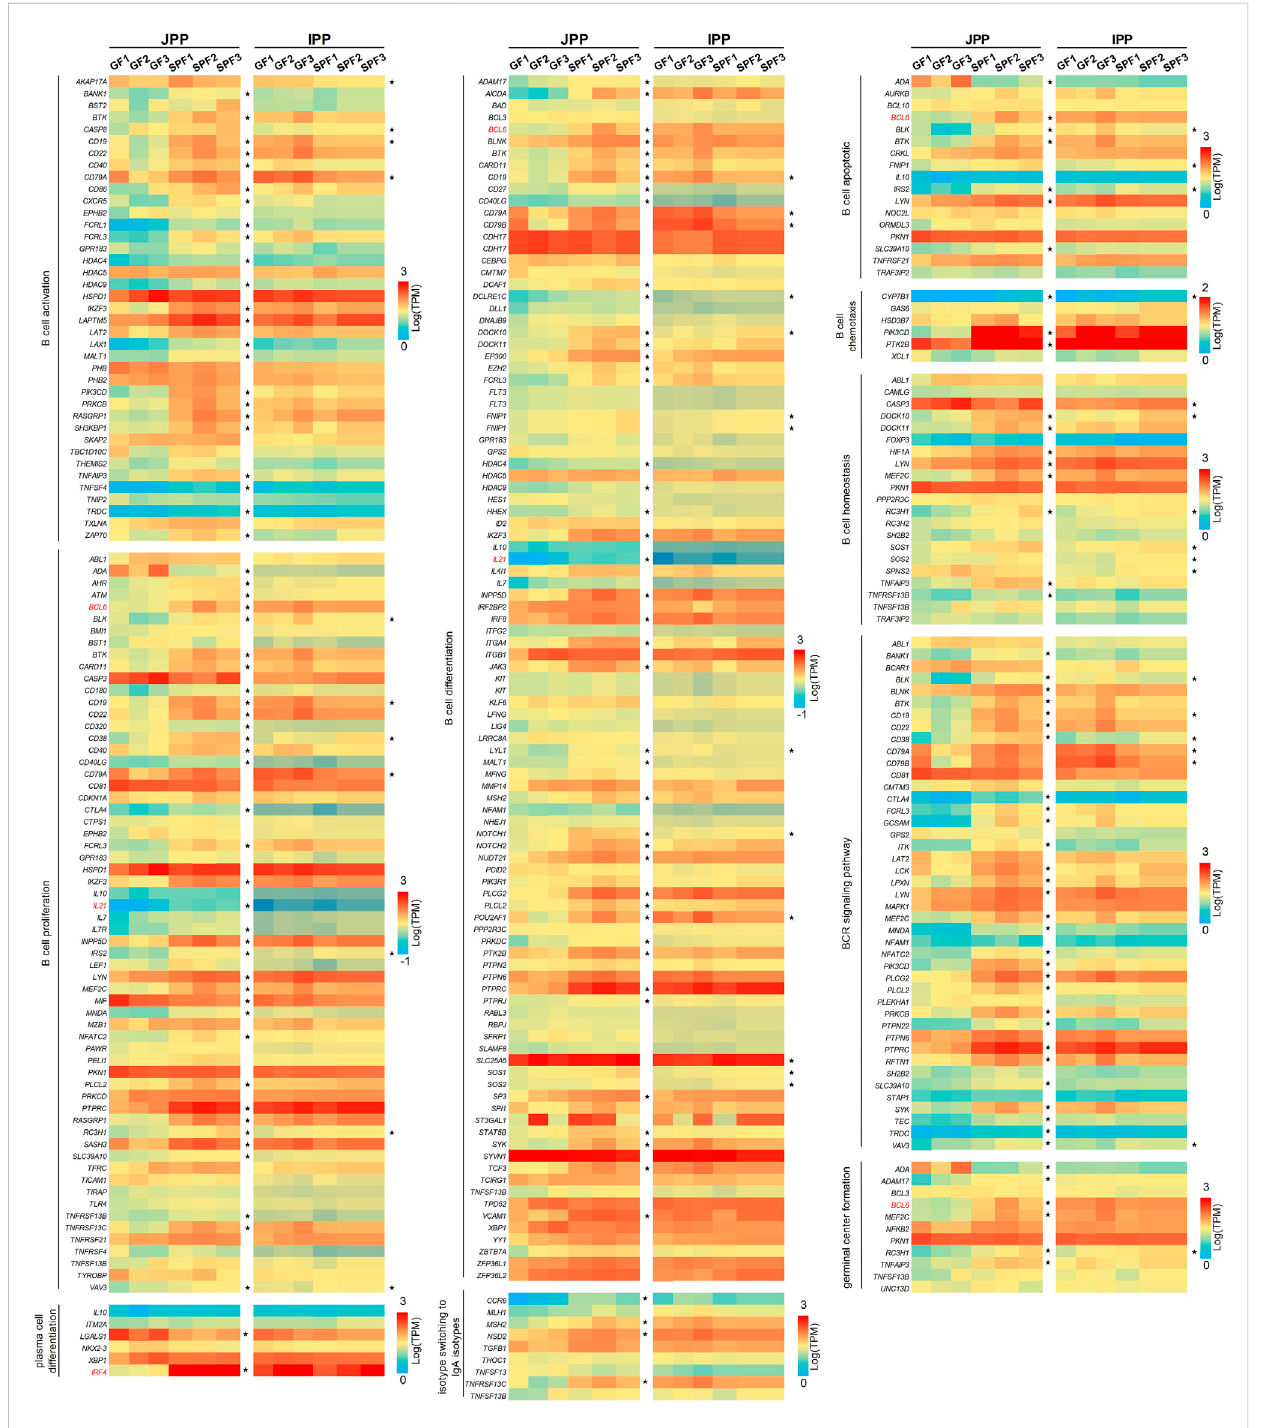
FIGURE 5 The expression pro fi les of B cell function-related genes. B cell function-related genes were involved in 10 biological processes. The expression levels of these genes (only one-to-one pig ortholog genes were used) are presented as a heatmap [Log(TPM)]. The genes marked in red ( IFR4 , BCL6 and IL21 ) are mentioned in the “ Discussion ”